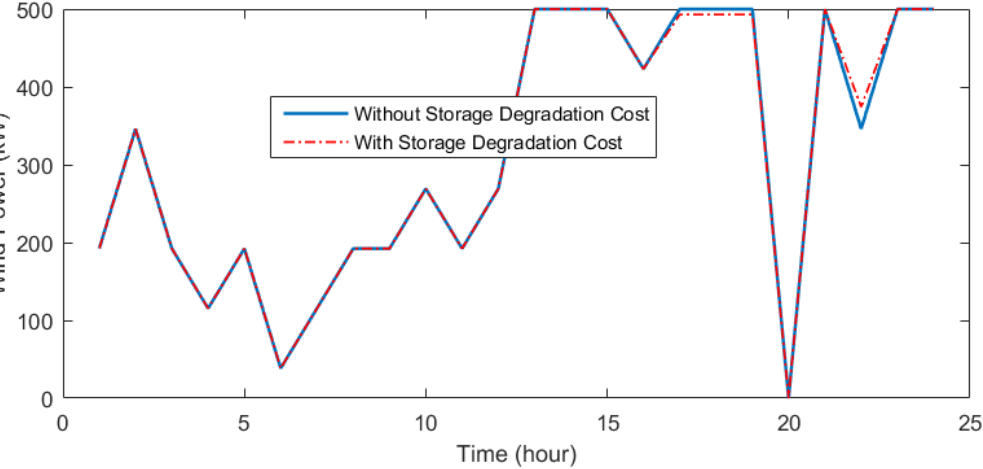
Figure 11. Contribution of different components without and with BDC in WT/Battery scheduling using the IFLA.